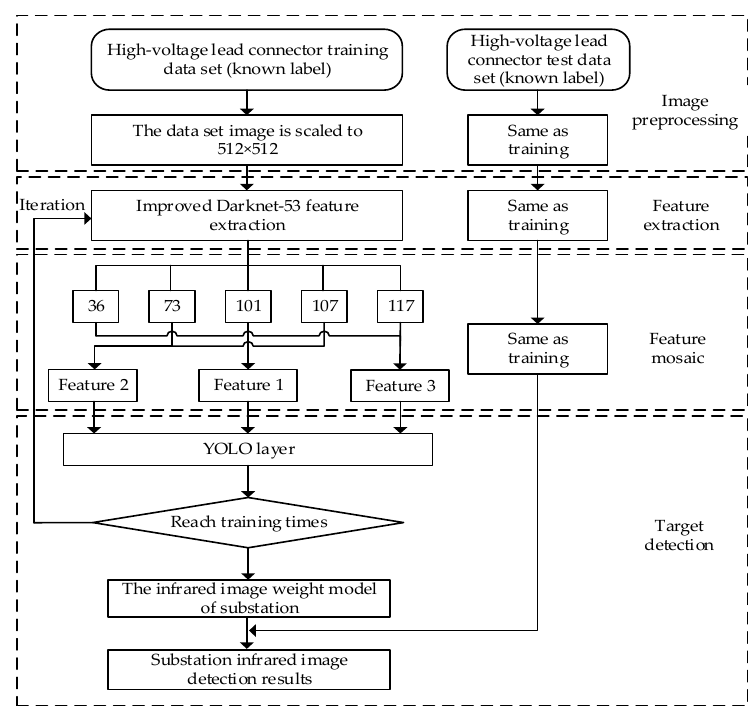
Figure 6. The flow diagram of the detection structure.